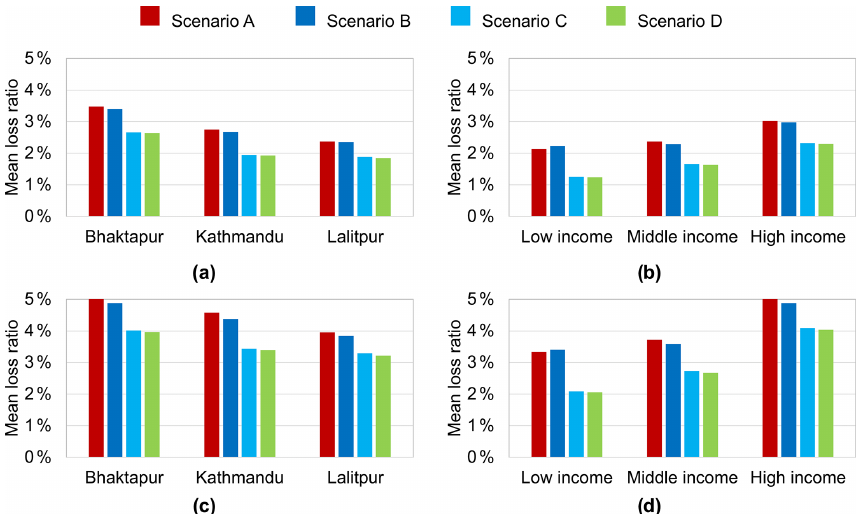
Figure 9. Mean loss ratios disaggregated by (a, c) district and (b, d) income level, corresponding to the (a, b) 100-year and (c, d) 1000-year flooding